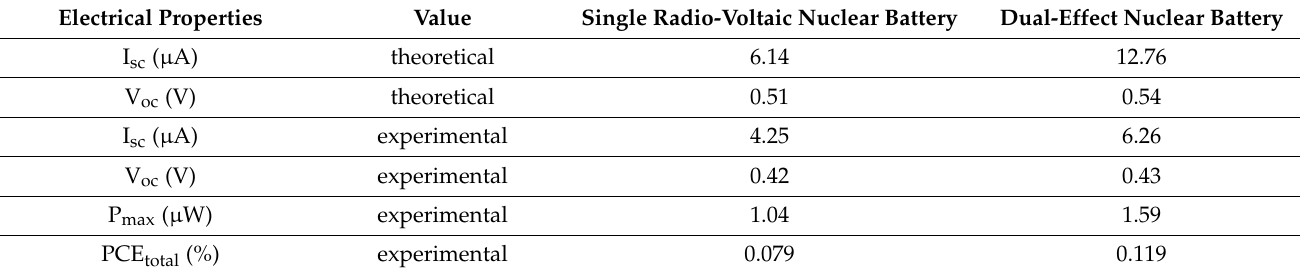
Figure 11. The schematic of Cd-109 dual-effect nuclear battery. Copyright permission from [132]. Table 6. Electrical performance parameters of nuclear batteries. Copyright permission from [132].